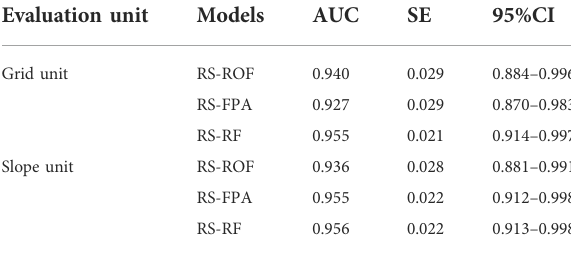
TABLE 6 Parameters of ROC curves using the validation